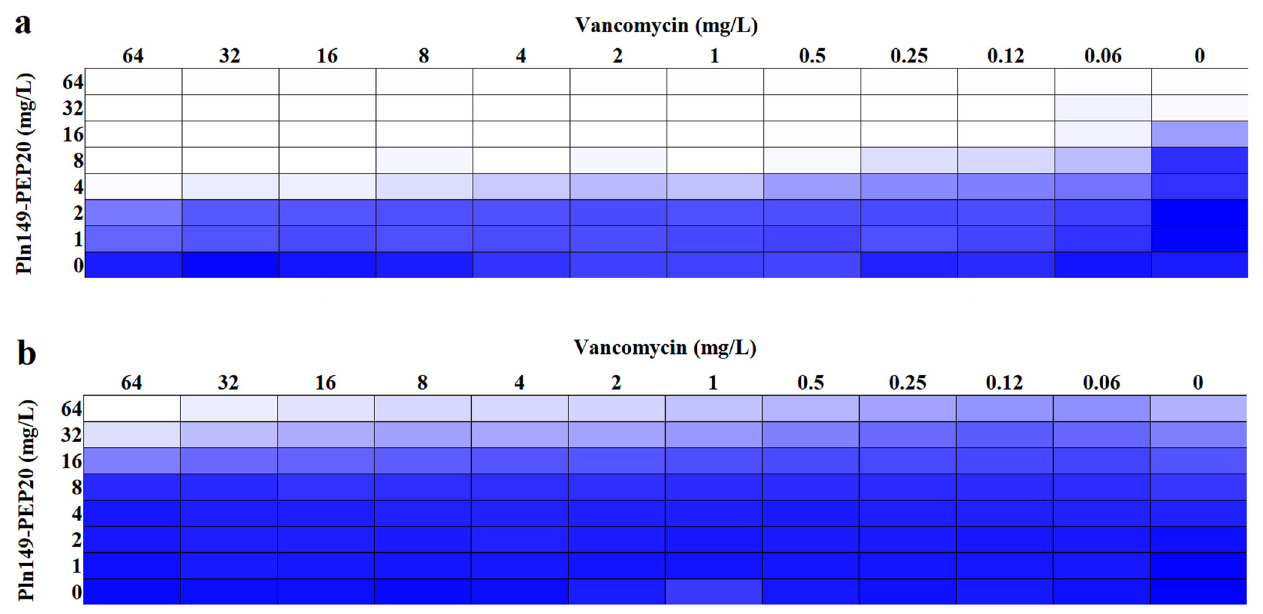
Figure 3. Heat map of synergism between Pln149-PEP20 and vancomycin ( a ) without and ( b ) with the addition of Mg +2 for A. baumannii ATCC 19606. The blue color represents the average absorbance of bacterial growth of three biological replicates.